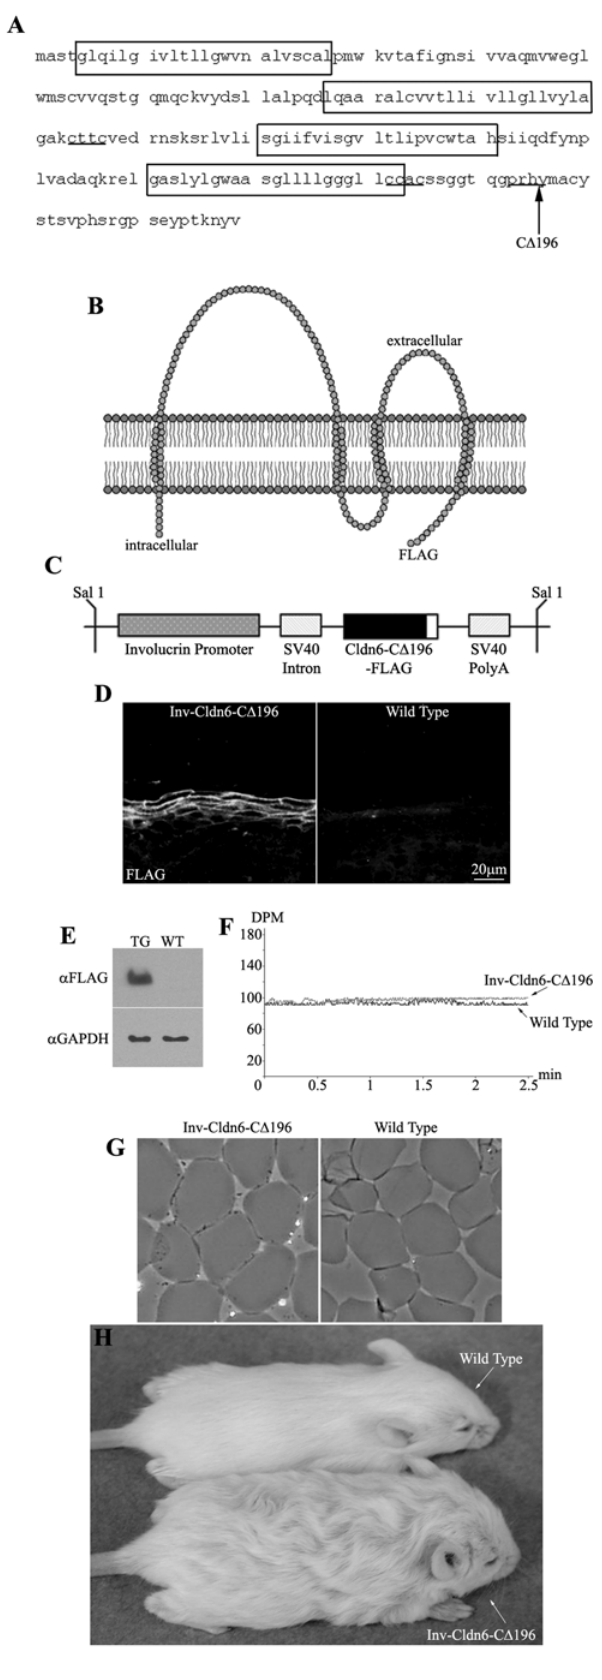
Figure 1. Inv-Cldn6-C D 196 transgenic mice. The Cldn6 protein sequence is shown; transmembrane-spanning regions are encased within boxes, the CXXC motifs are underlined, and the truncation site is indicated with an arrow ( A ). The Inv-Cldn6-C D 196 mutant was created by deleting the C-terminal half of the cytoplasmic tail domain of Cldn6 after amino acid 196 ( B ). The Inv promoter was use to drive transgene expression to the suprabasal compartment of the transgenic mouse epidermis, where TJs are localized ( C ). Transgene expression was confirmed to be restricted to the upper spinous and granular layers of the epidermis as visualized by immunohistochemistry using anti-FLAG antibodies ( D ) and immunoblotting confirmed a , 19.5kDa band corresponding to the transgene product in skin samples from transgenic (TG) but not wild type (WT) skin samples using anti-GAPDH as a loading control ( E ). Trans-epidermal water loss measurements confirmed no skin barrier dysfunction in the Inv-Cldn6-C D 196 transgenic mice at birth ( F ). This was further supported by evaluation of cornified envelopes; which were characterized by a rigid shape and uniform size comparable to that of the wild type ( G ). Inv-Cldn6-C D 196 mice were easily identifiable by their frizzed and lackluster coat appearance as compared to the wild type, a phenotype that persisted throughout life ( H ).